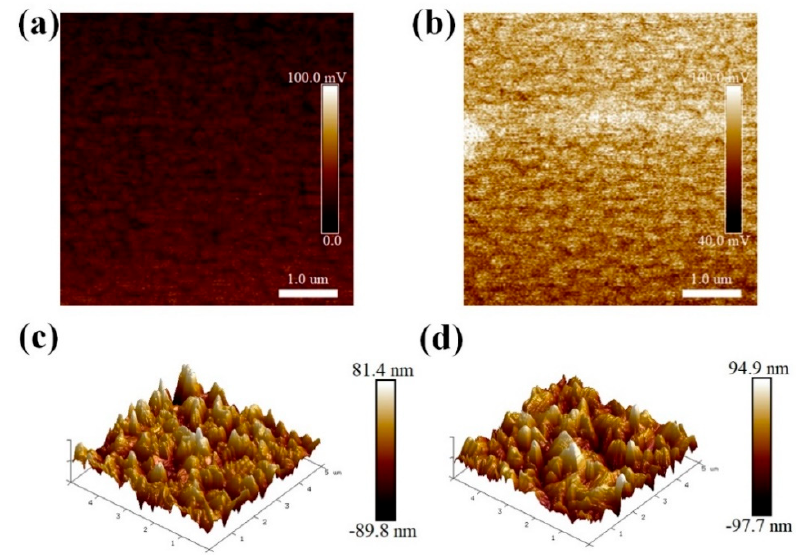
Figure 2. ( a , b ) Kelvin probe force microscopy (KPFM) images of fluorine-doped tin oxide (FTO) substrates without and with PEI modification (8 mg / mL), respectively. ( c , d ) Three-dimensional (3D) AFM images of CsPbIBr 2 films loaded on the FTO substrates without and with PEI modification (8 mg / mL), respectively.